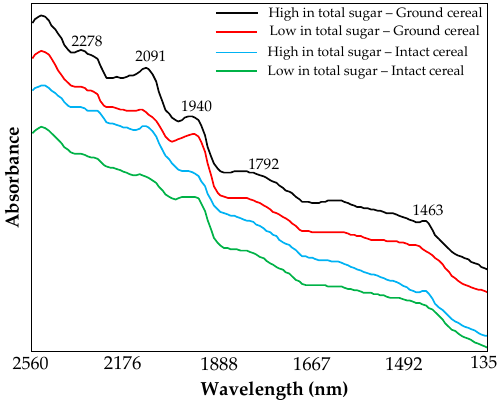
Figure 2. Raw FT-NIR spectra of ground and intact cereals (high and low in sugar content).